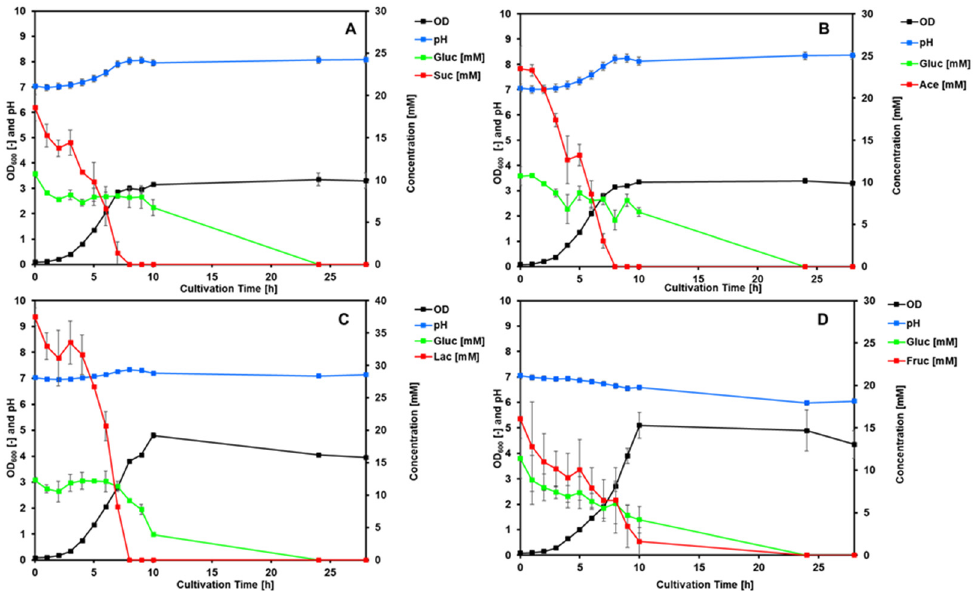
Figure 4. Comparison of substrate utilization by the type strain DSM 2944 T . Glucose was co-fed with different organic acids to determine diauxic growth, with fructose as a control. The glucose start concentration was chosen to be 10 mM, while the start concentrations of the second carbon sources were 2–3 times higher. The error bars represent the standard deviation of duplicates. The four graphs show the co-feeding of 10 mM glucose with ( A ) 20 mM succinate; ( B ) 25 mM acetate; ( C ) 40 mM lactate; and ( D ) 20 mM fructose.